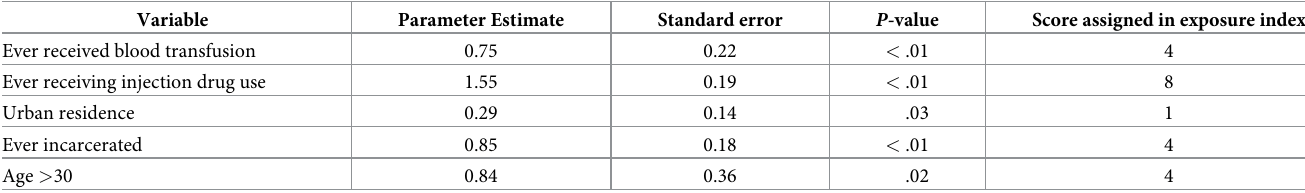
Table 3. Final HCV predictive model for males, parameter estimates and score assigned.